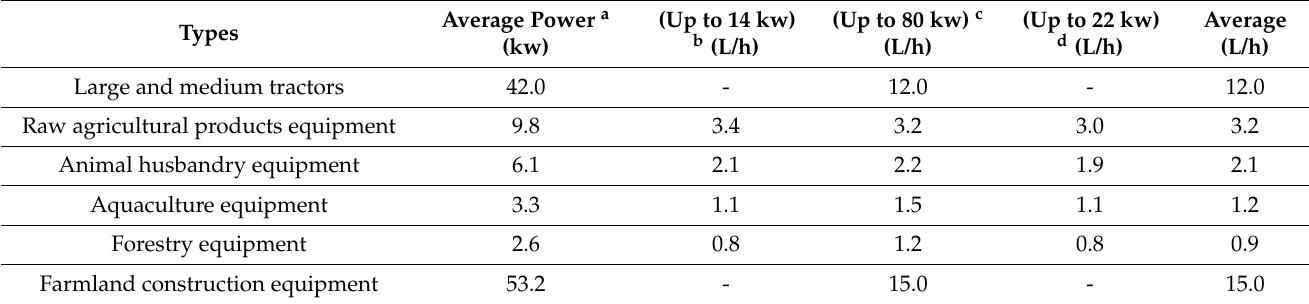
a : Table 1; b : Figure 2a, c : Figure 2b; d : Figure 2c.